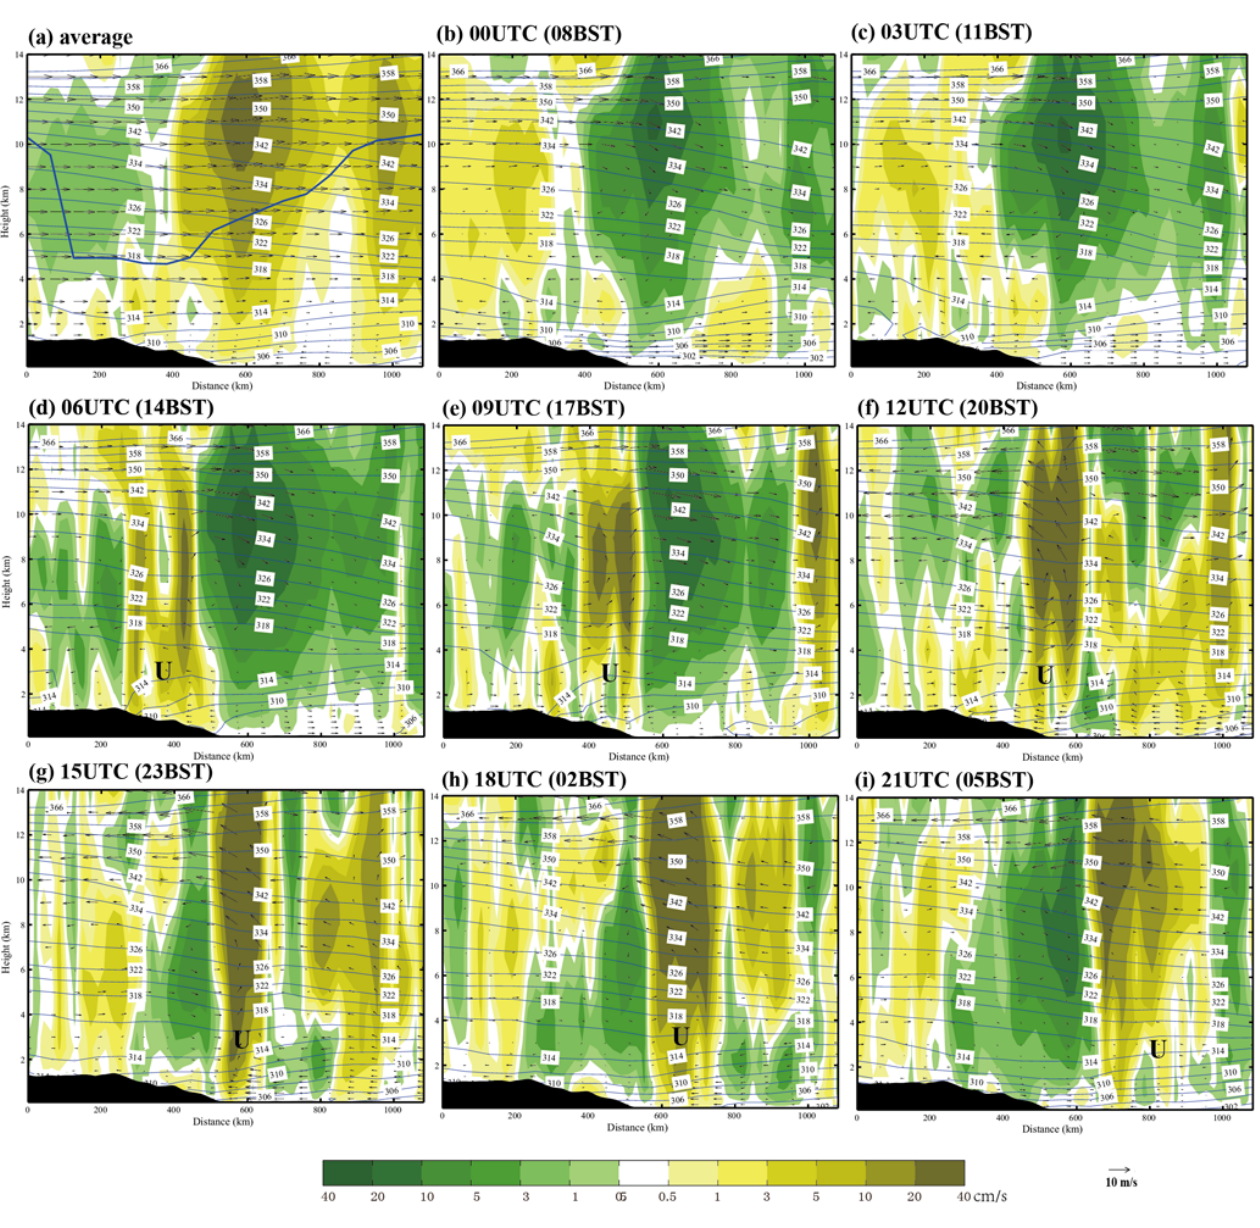
Fig. 11. As in Fig. 10, but for NOVAP